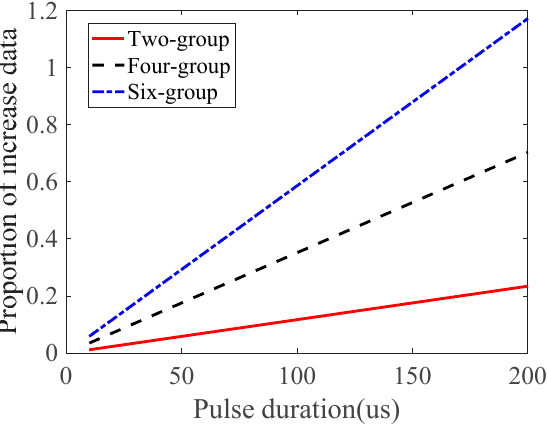
Figure 8. Relationship between the increased data ratio and the transmitted pulse duration.